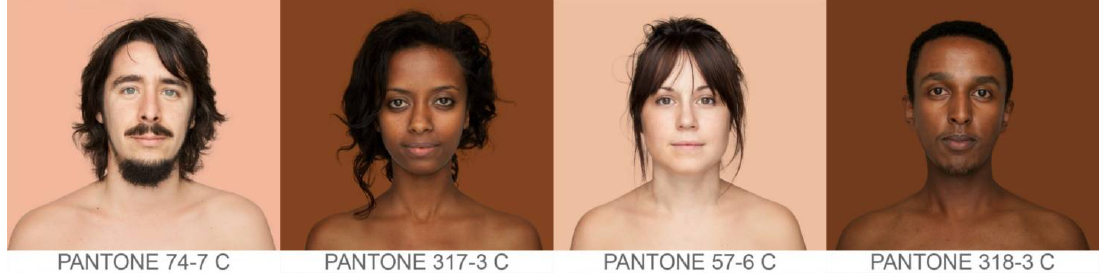
Figure 2. Final photographs choice. Courtesy of Angélica Dass